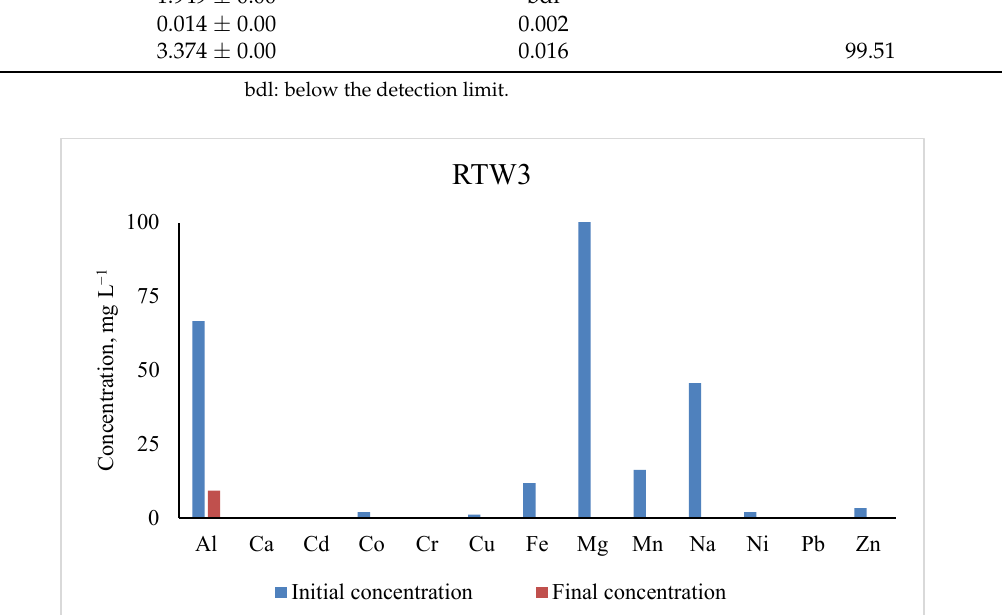
Figure 9. Initial and residual concentrations of metals in water samples collected from RTW3. The pH of AMD collected from sampling site RTW3 was greater than the other pH values observed in the previous sampling sites. This might be caused by the presence of Na, Mg and Al in high concentrations. Both Pd (14.0 µ g L − 1 ) and Cr (92.0 µ g L − 1 ) did not meet the SANS 241-2015 ( ≤ 10 µ g L − 1 and ≤ 50 µ g L − 1 , respectively) (Table 3) before the treatment, while Pd (2 µ g L − 1 ) met the standards after treatment and Cr was below the detection limit. Fe, as the main target element, was completely removed with a removal efficiency of 99.85%. In conclusion, sodium ferrate showed its potential of removing metals through coagulation and flocculation processes from raw tailing waters characterized with an acidic pH, and the residual concentrations of most elements detected in all AMD samples were below the SANS 241-2015 and WHO guidelines [29] of drinking water with a resultant pH ≥ 9. Na 2 FeO 4 became the promising alternative material for water processing and mining wastewater with zero energy input and non-toxic by-products. The novelty of this paper relied on the treatment of AMD, using an advanced oxidation process (AOP), which is sodium ferrate (VI) in a single mixing of a dosing unit, where generated ferric ions from the breakdown of this AOP acts as an effective coagulant and flocculent in the form of